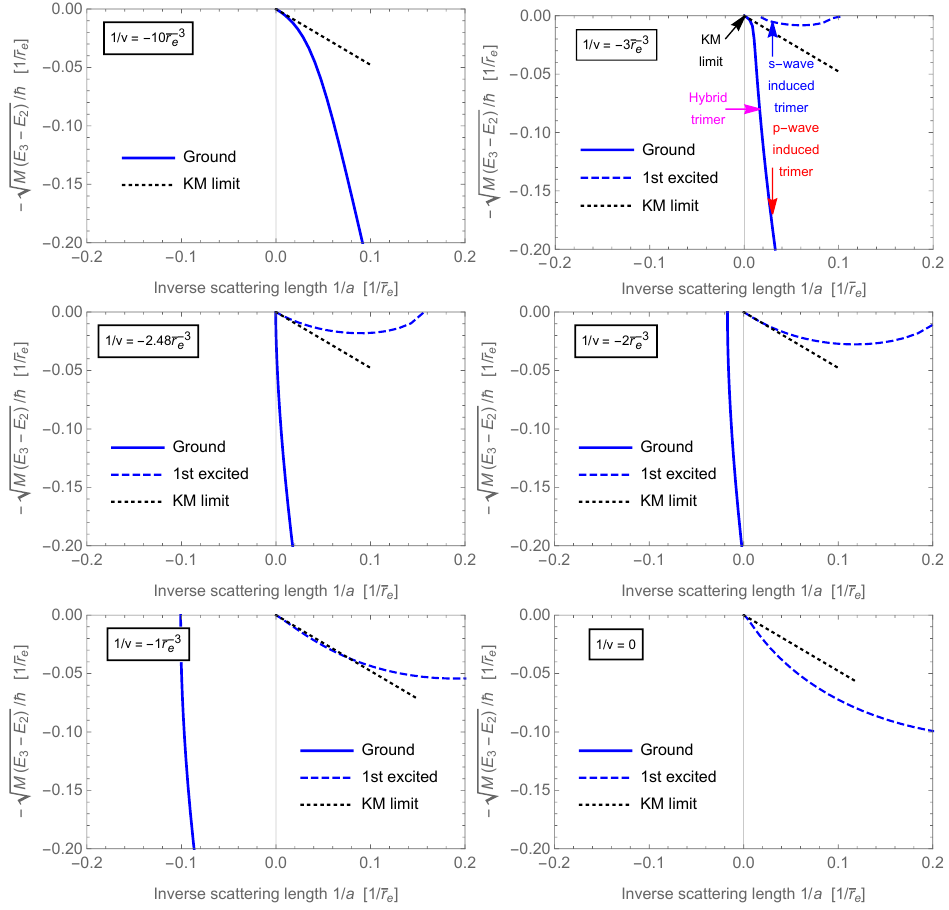
Figure 6: Dependence of the spectrum on the scattering volume v between fermions, for increasing values (in magnitude) of v , until a p-wave resonance is reached ( v = −∞ ). The results are obtained with the p-wave Gaussian model, and both the ground (solid curve) and excited (dashed curve) trimer states are shown. In order to distinguish the excited state, the three-body energy is measured from the two-body energy E (which is either zero for negative scattering lengths, or the dimer energy 2 for positive scattering lengths) and then converted to a wave number. In this fashion, the Kartavtsev–Malykh zero-range limit corresponds to a straight line shown in black dots. The arrows indicate the states for which the wave functions of Fig. 7 have been computed. The ground state is shown for a wider range of scattering lengths in Fig.